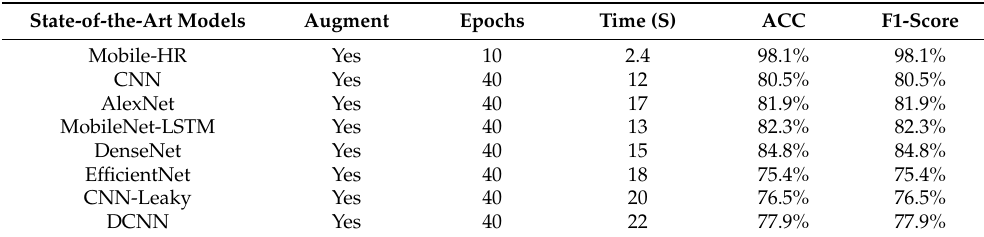
Table 8. Computational performance of state-of-the-art models with data augmentation and other deep learning techniques compared to the proposed model.